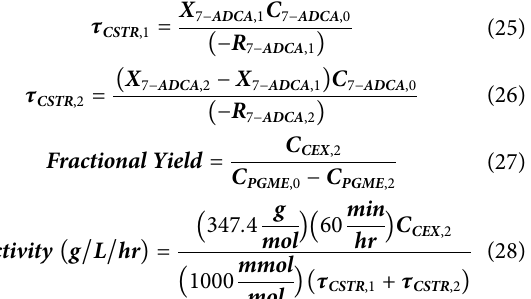
Frontiers in Bioengineering and Biotechnology |